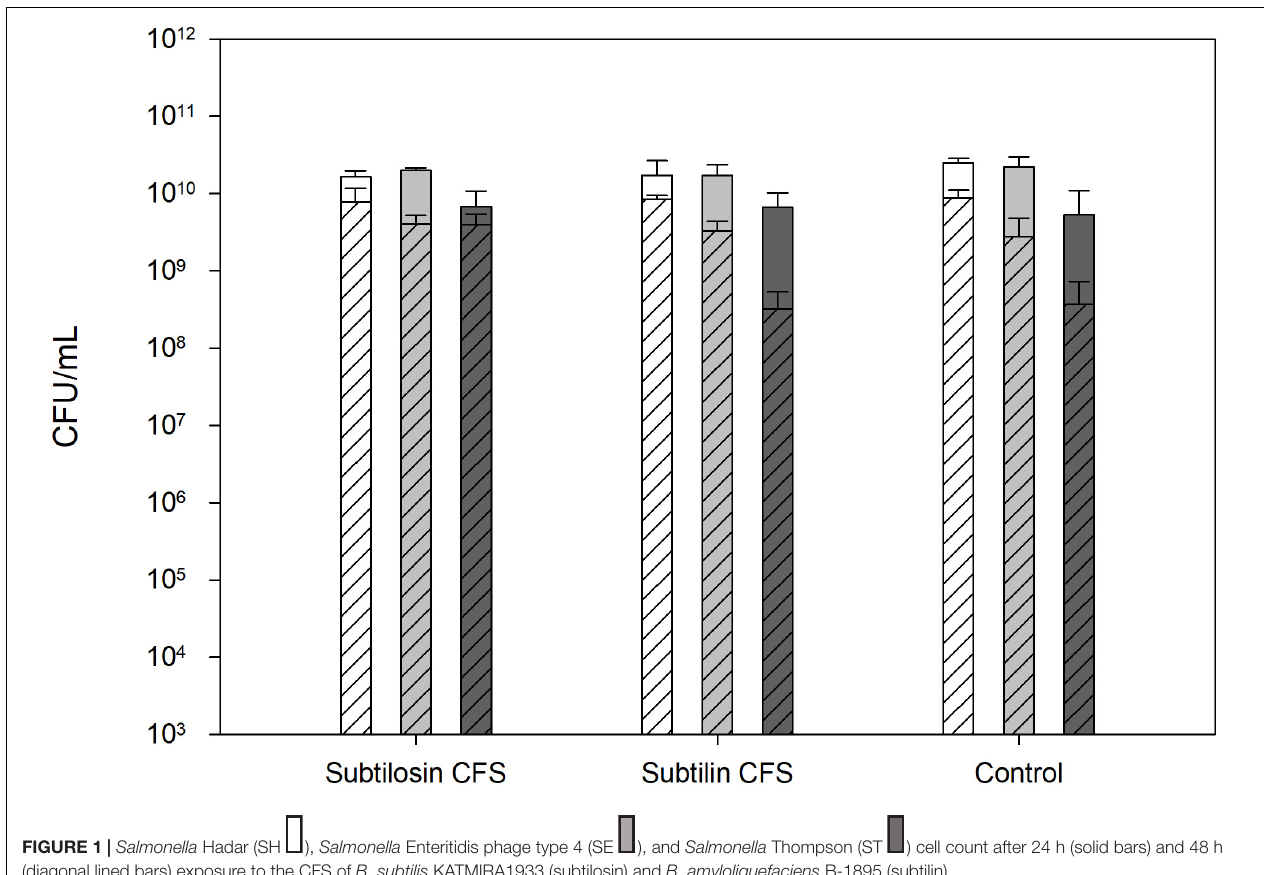
FIGURE 1 | Salmonella Hadar (SH ), Salmonella Enteritidis phage type 4 (SE ), and Salmonella Thompson (ST ) cell count after 24 h (solid bars) and 48 h (diagonal lined bars) exposure to the CFS of B. subtilis KATMIRA1933 (subtilosin) and B. amyloliquefaciens B-1895